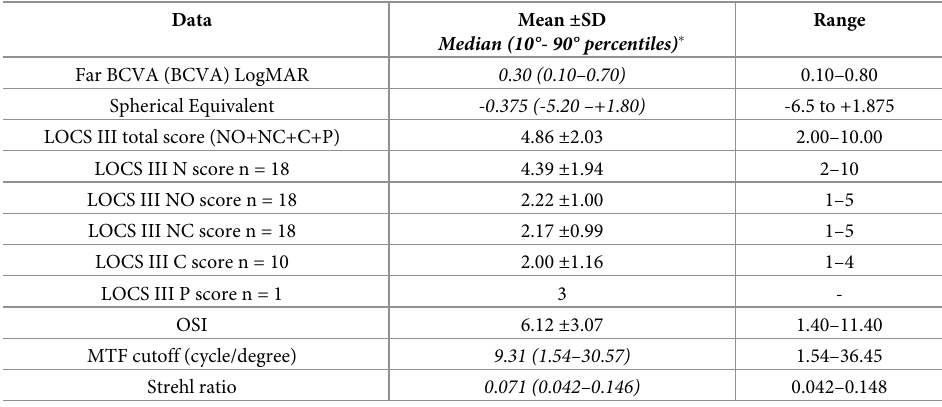
Table 1. Preoperative baseline data (n = 21 eyes).